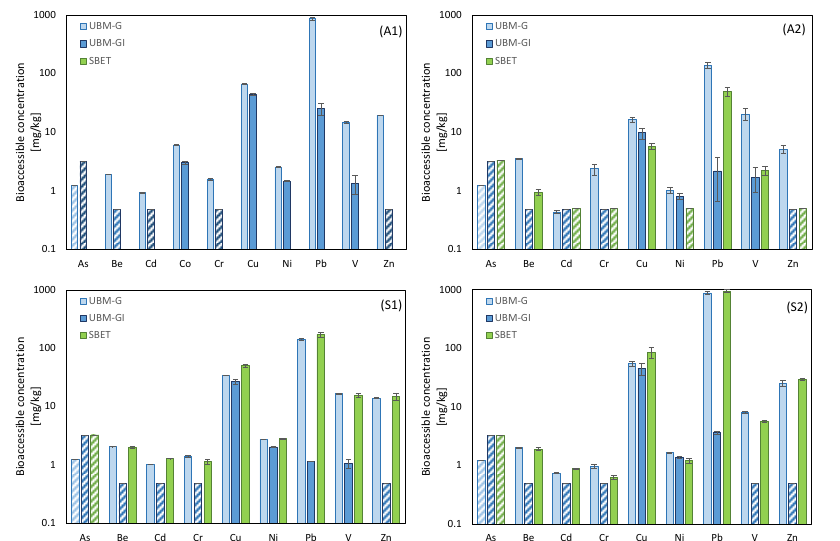
Figure 3. Comparison of the bioaccessibile concentrations obtained applying UBM (UBM-G: gastric phase; UBM-GI: gastro-intestinal phase) and SBET to samples A1 , A2 , S1 , and S2 . The striped bars represent values below the limit of